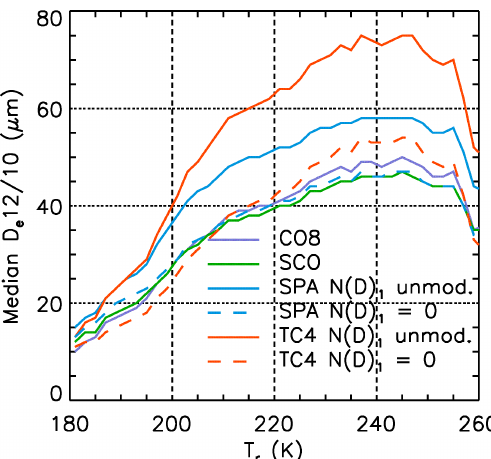
Figure 11. Median D e 12 / 10 from the V4 CO8 (purple) and SCO (green) models, and from analytical functions derived by Mitchell et al. (2018) during the SPARTICUS (blue) and TC4 (red) field ex- periments using N(D) 1 unmodified (solid) or N(D) 1 = 0 (dashed). This is the same dataset as the one in Fig.